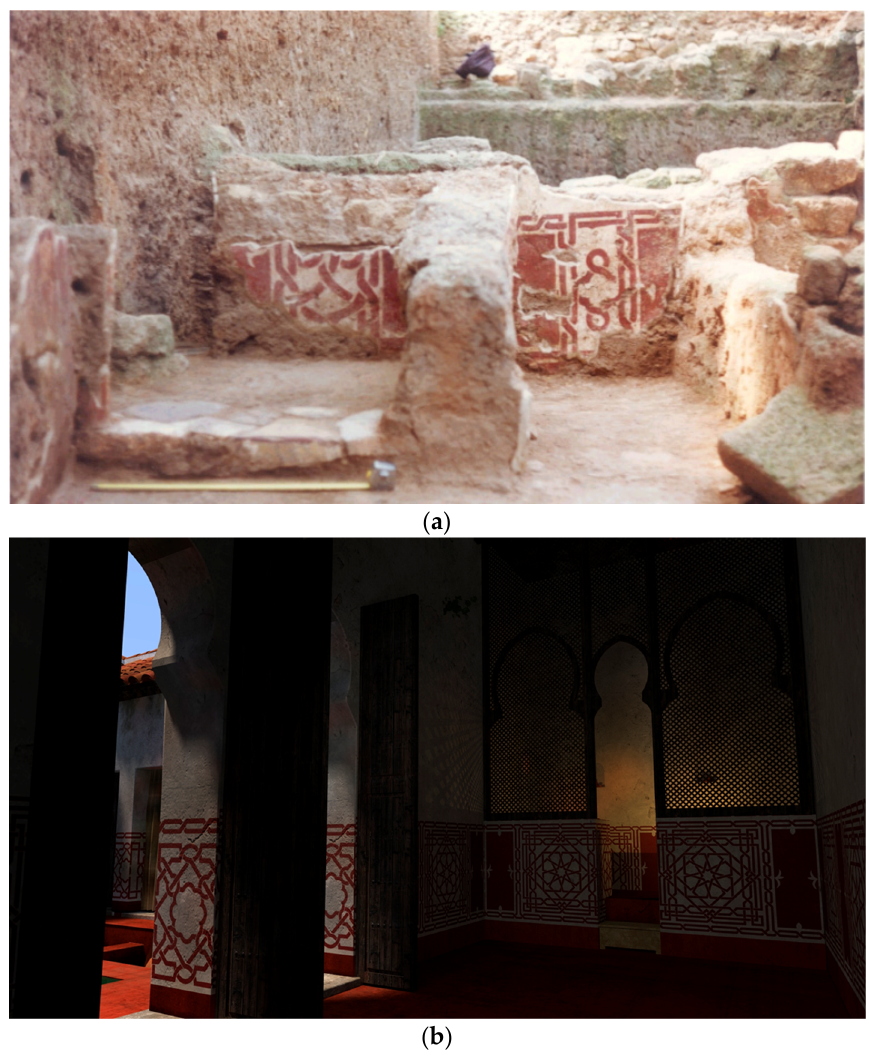
Figure 7. ( a ) Latrine in an Islamic house in the Palacio de Orive (Murillo et al. 1992); ( b ) 3D recon- struction of the Palacio de Orive’s house (R. Blanco-Guzmán y J.M. Tamajón).